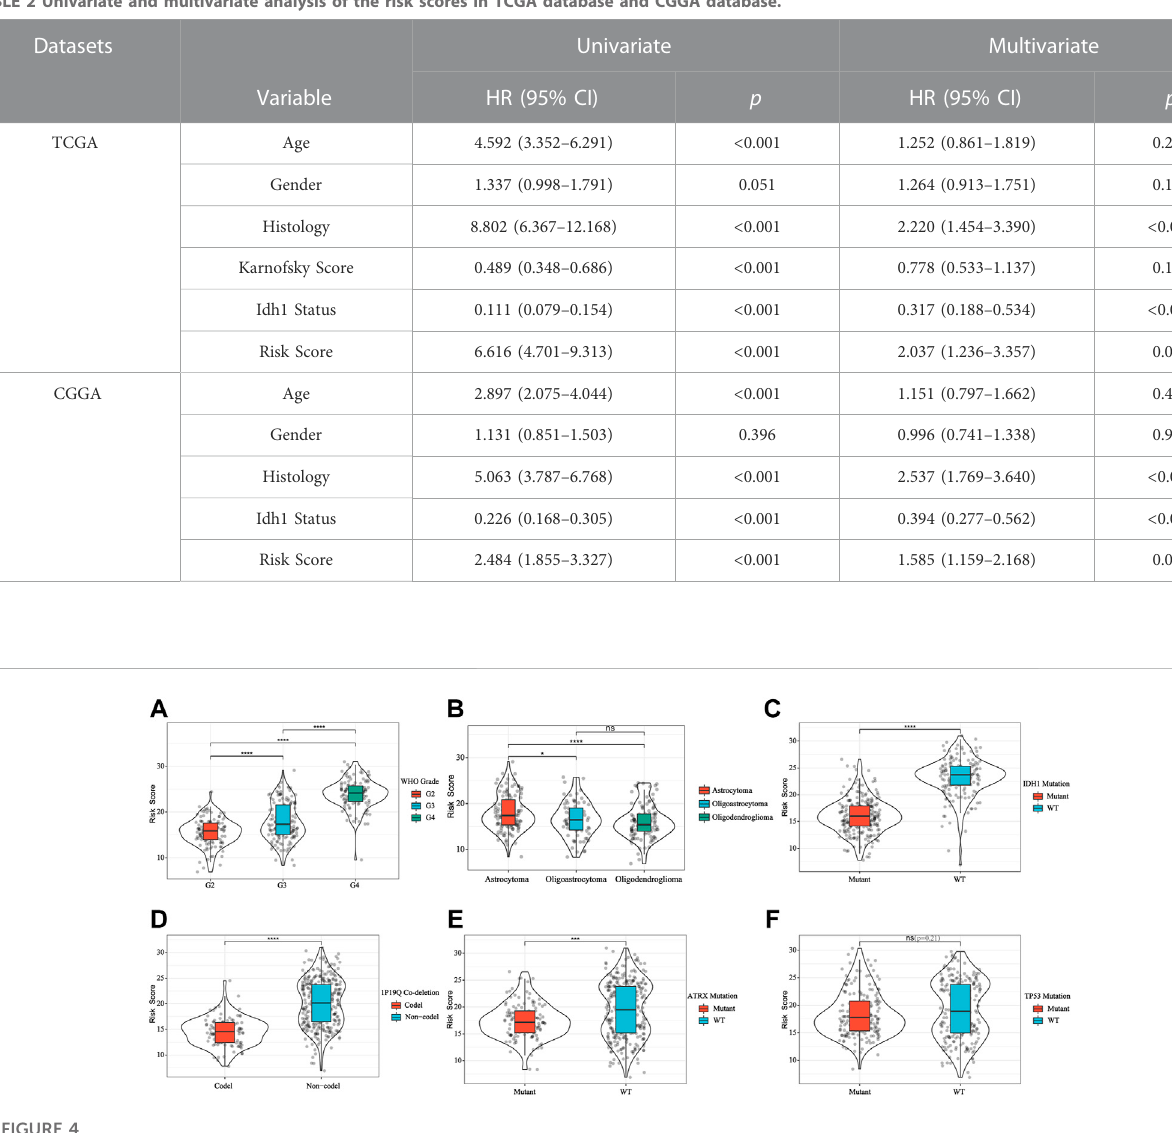
(Table 2). Kaplan-Meier analysis of differential survival between the two groups found that patients in the high-risk group had signi fi cantly worse survival (shorter survival duration and lower survival) than those in the low-risk group ( p < 0.0001) (Figure 3C). To verify the superiority of our risk scoring model,